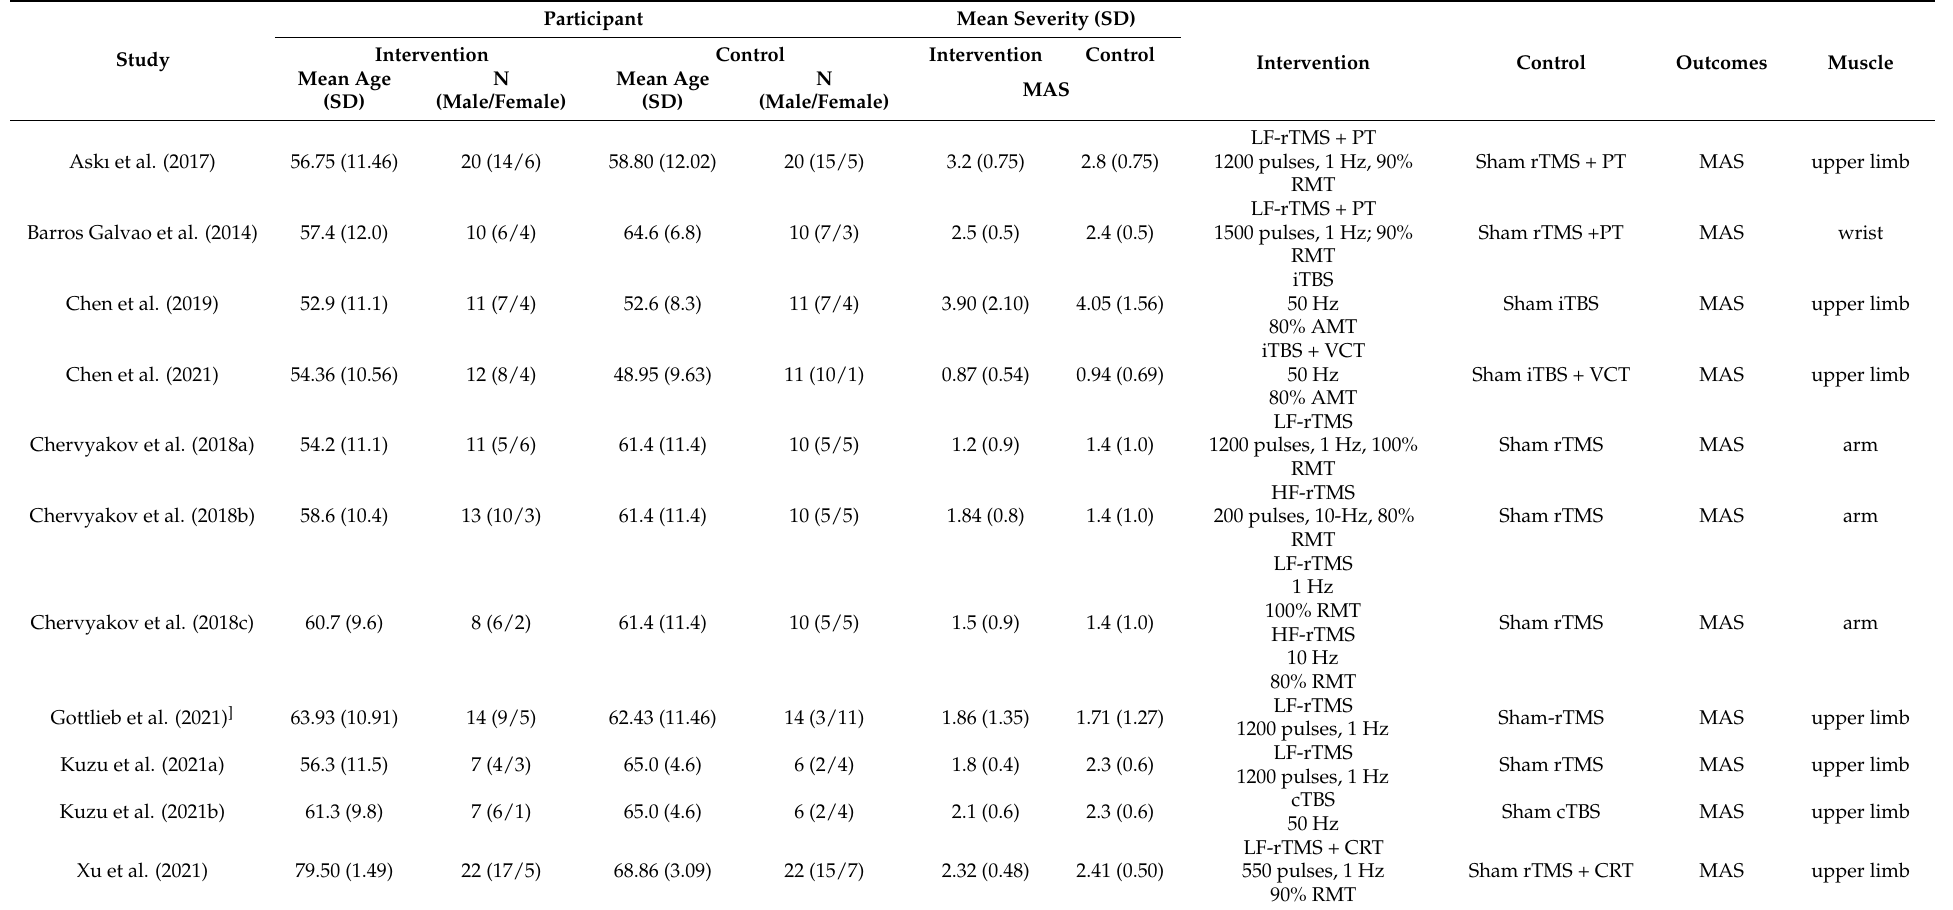
Table 1. Research Characteristics of